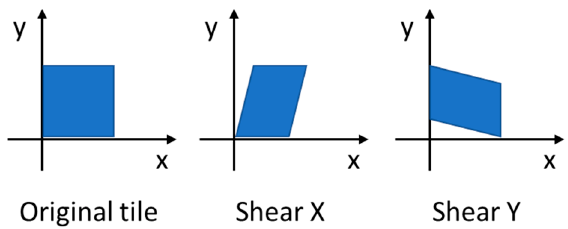
Figure 8. Shear transformation in 2 directions.